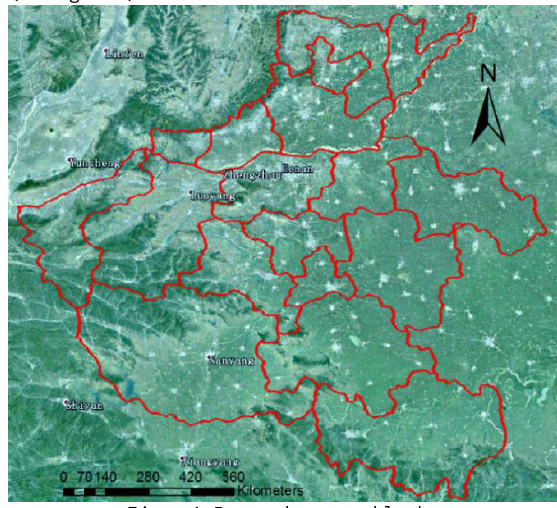
Figure 1. Research area and